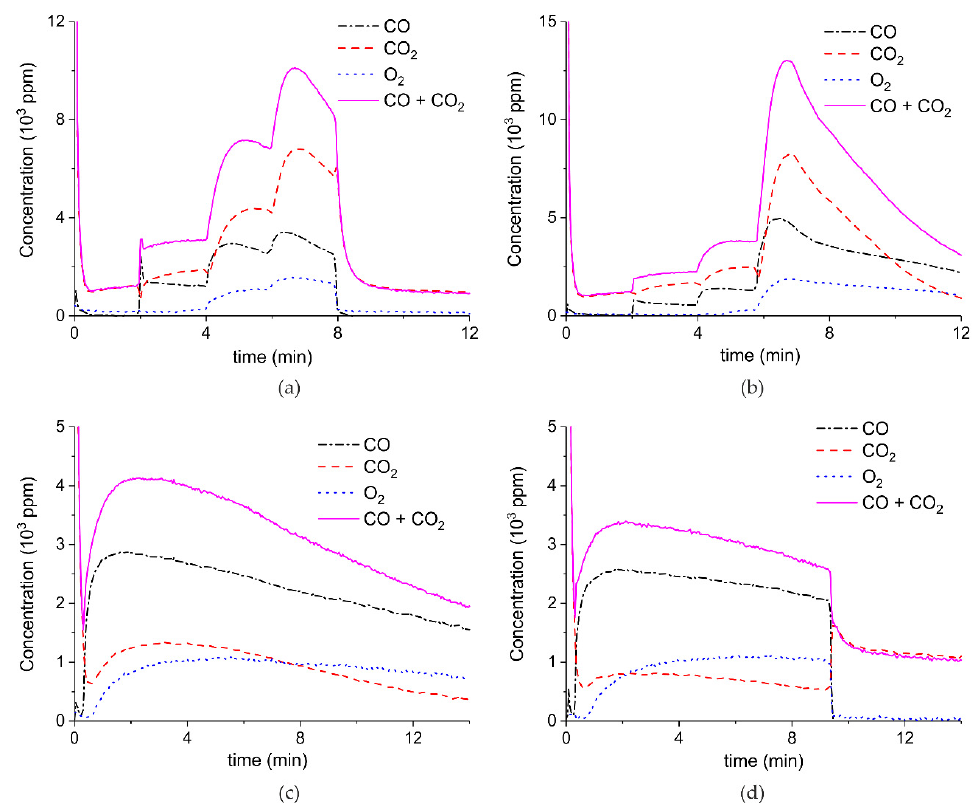
Figure A2. Concentration of the products of CaCO 3 decomposition (sample B) as function of time at 630°C in pure argon and flow rate of 30 mL/min. Plasma power is 1, 4.1, and 5.8 W ( a ); 0.5, 2.1, and 8.5 W ( b ); and 2.1 W ( c,d ). Plasma is turned on after 2 min and changed every 2 min (a,b) or at the beginning of the decomposition (c,d).